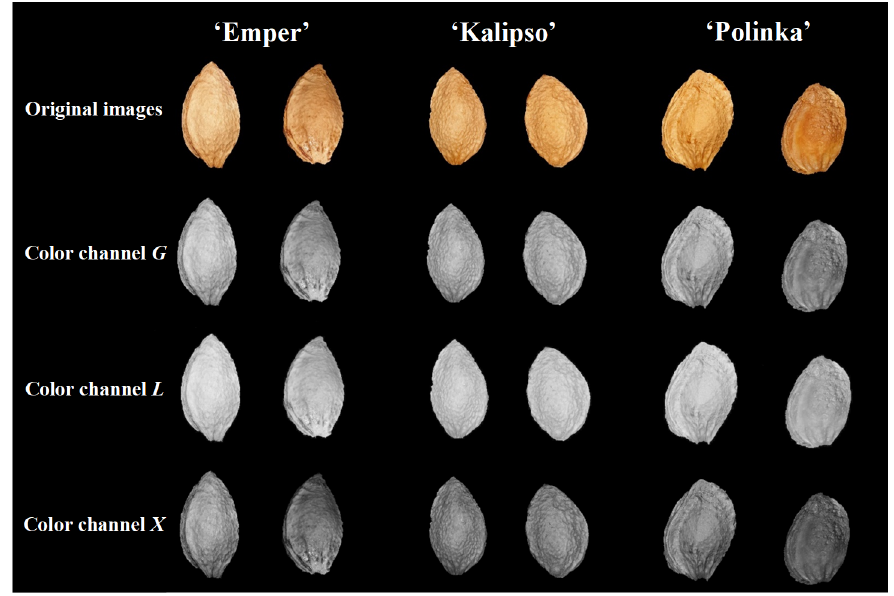
Figure 2. The plum stone images converted to different color channels.